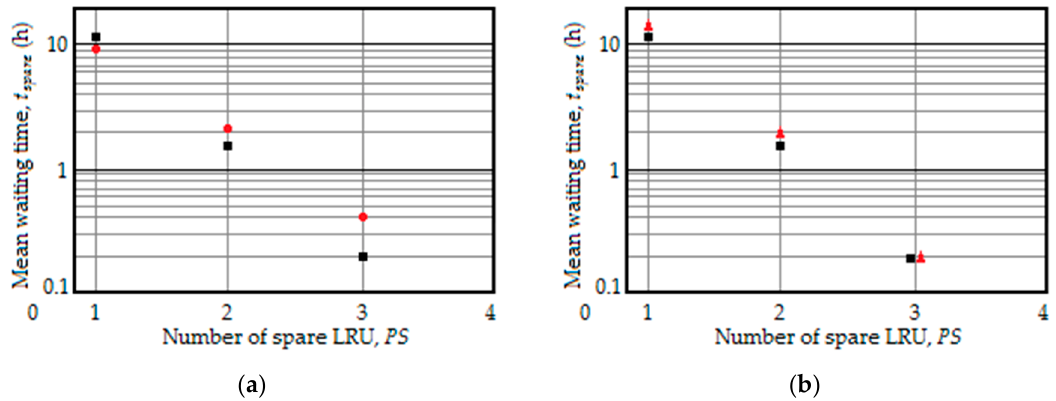
Figure 9. Dependences of the mean waiting time on the number of planned spare LRU ( PS ) for the second WM option; ( a ) 𝜃 = 1 × 10 (cid:2879)(cid:2872) h (cid:2879)(cid:2869) , red circles: 𝑃 (cid:3033)(cid:3039)(cid:3036)(cid:3034)(cid:3035)(cid:3047)(cid:3007)(cid:3017) = 1 × 10 (cid:2879)(cid:2872) , black squares: 𝑃 (cid:3033)(cid:3039)(cid:3036)(cid:3034)(cid:3035)(cid:3047)(cid:3007)(cid:3017) = 1 × 10 (cid:2879)(cid:2871) ; ( b ) 𝑃 (cid:3033)(cid:3039)(cid:3036)(cid:3034)(cid:3035)(cid:3047)(cid:3007)(cid:3017) = 1 × 10 (cid:2879)(cid:2872) , black circles: 𝜃 = 1 × 10 (cid:2879)(cid:2872) h (cid:2879)(cid:2869) , red triangles: 𝜃 = 1 × 10 (cid:2879)(cid:2871) h (cid:2879)(cid:2869) .